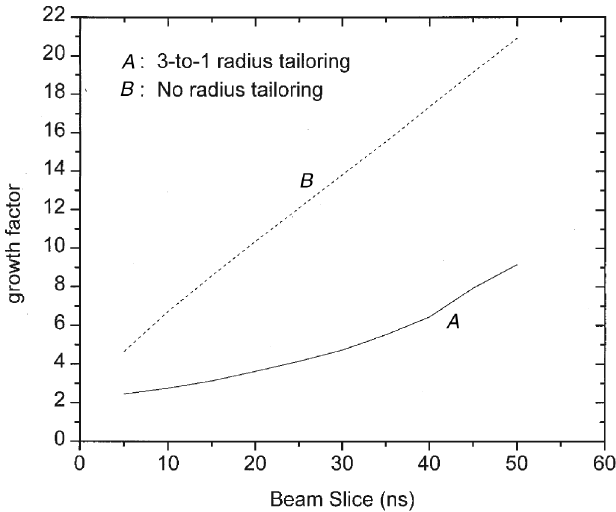
FIG. 6. Same as Fig. 5 for a 300 MeV, 2 kA, 1 cm radius proton